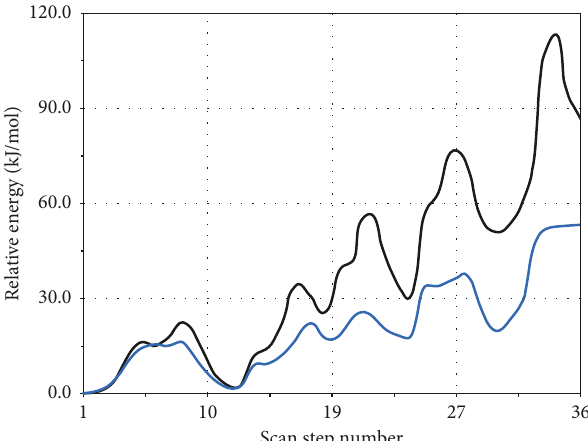
Figure 8: Relative energy due to simultaneous scans (steps represent dihedral angles at each point of coordinates shown in Figure 8 and precisely defined in the insets of Figure 10): D-S1 twisting (black line) and D-S2 (blue